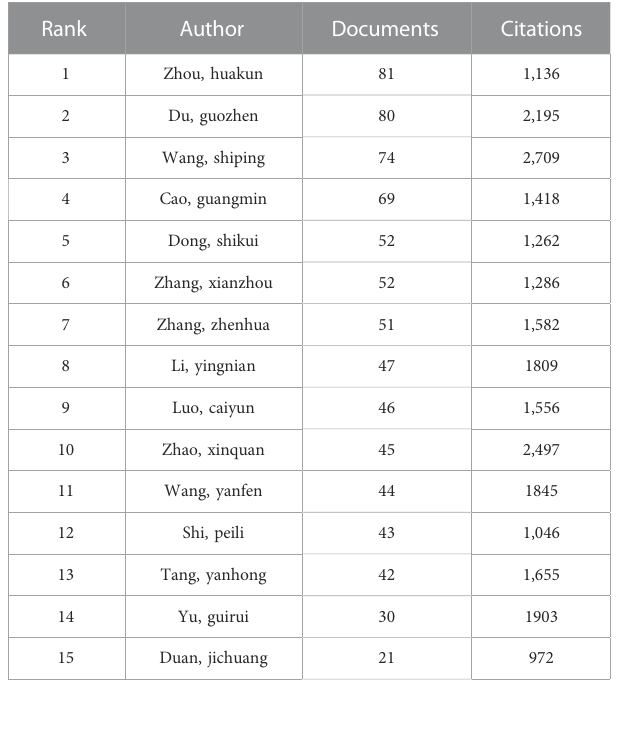
TABLE 1 Top 15 published authors in the fi eld of alpine meadows.